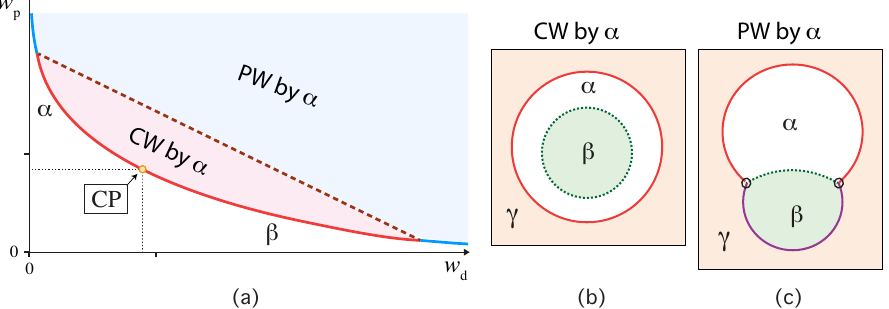
Figure 13. Schematic phase diagram and wetting morphologies of aqueous PEG-dextran solutions within giant vesicles, with the PEG-rich phase α and the dextran-rich phase β : ( a ) Phase diagram of PEG-dextran solutions at room temperature as in Figure 4. The phase diagram exhibits a one-phase region (white) at low weight fractions w d and w p of the two polymers and a two-phase region (light red and light blue) at higher weight fractions. The boundary between the one-phase and two-phase regions defines the binodal line which contains the critical demixing point (CP, orange). The two-phase region above the binodal is divided up into two subregions, a complete wetting (CW) subregion (light red) close to the critical point and a partial wetting (PW) subregion (light blue) further away from it. The boundary between the CW and PW subregions is provided by a certain tie line (purple dashed line), the precise location of which depends on the lipid composition of the membrane; ( b ) CW morphology and ( c ) PW morphology of the vesicle-droplet system corresponding to complete and partial wetting of the vesicle membrane by the α phase, corresponding to the light red and light blue subregions of the phase diagram in panel a